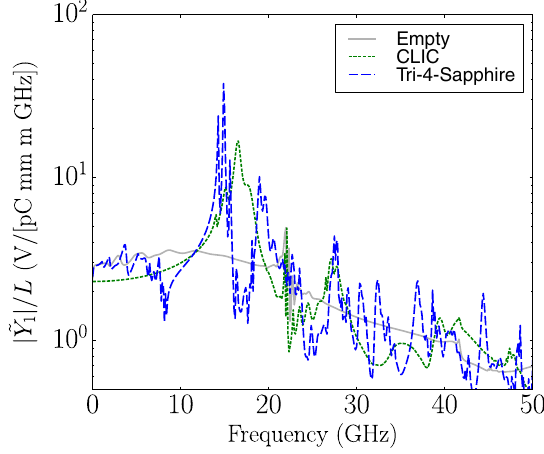
FIG. 8. The higher transverse wake in the Tri-4-Sapphire cavity is due to the cluster of “ high ” - Q modes around 15